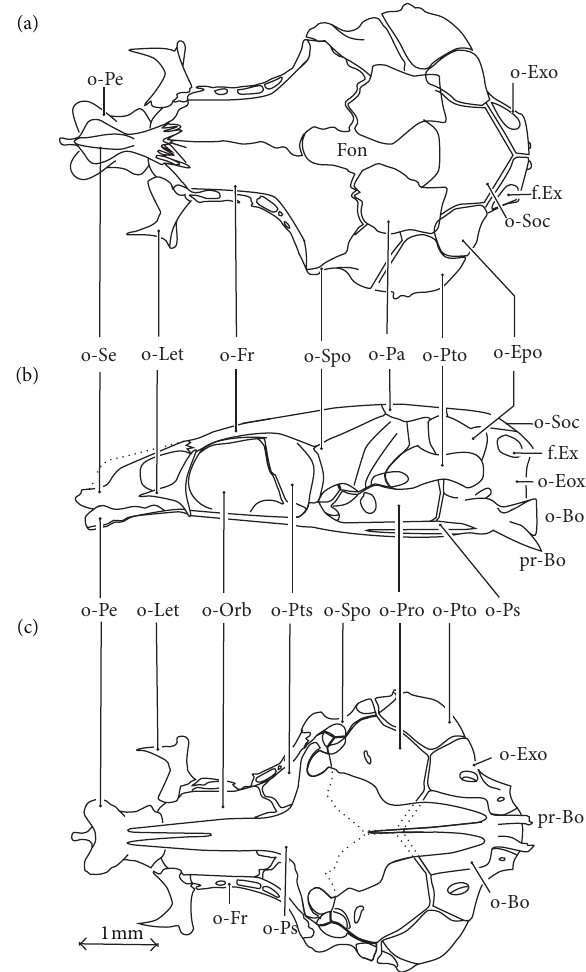
Figure 1: (a) Dorsal, (b) lateral, and (c) ventral views of the neurocranium of Oxynoemacheilus chomanicus . pr-Bo: basioccip- ital process; Bo: basioccipital; Epo: epiotic; Exo: exoccipital; fon: fontanelle; Fr: frontal; fr-Exo: foramen exoccipital; Let: lateral ethmoid; Orb: orbitosphenoid; Pa: parietal; Pe: prevomer; Pro: prootic; Ps: parasphenoid; Pto: pterotic; Pts: pterosphenoid; Se: supraethmoid-ethmoid; Soc: supraoccipital; Spo: sphenotic.